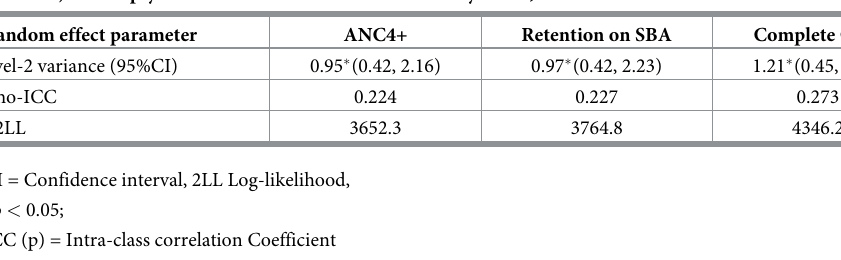
Table 4. A multilevel model of retention in the continuum of maternal healthcare services pathway (ANC, SBA, and PNC): An empty model without covariates in the Hadiya zone,